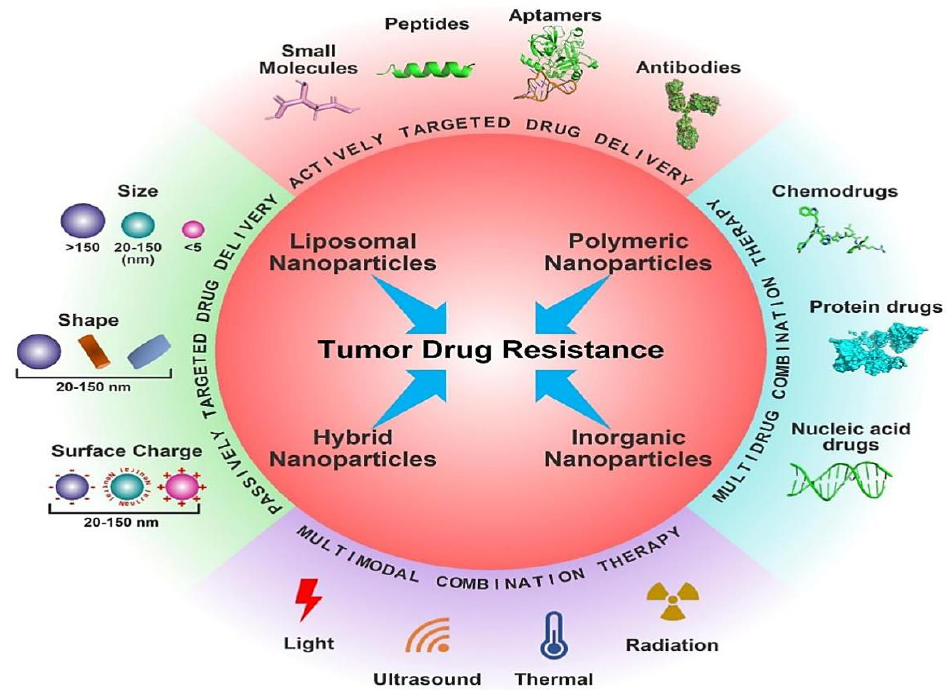
Figure 1. Different nanotherapeutic approaches for overcoming cancer drug resistance. Reproduced from Ref. [12], (2022), with permission from Elsevier.